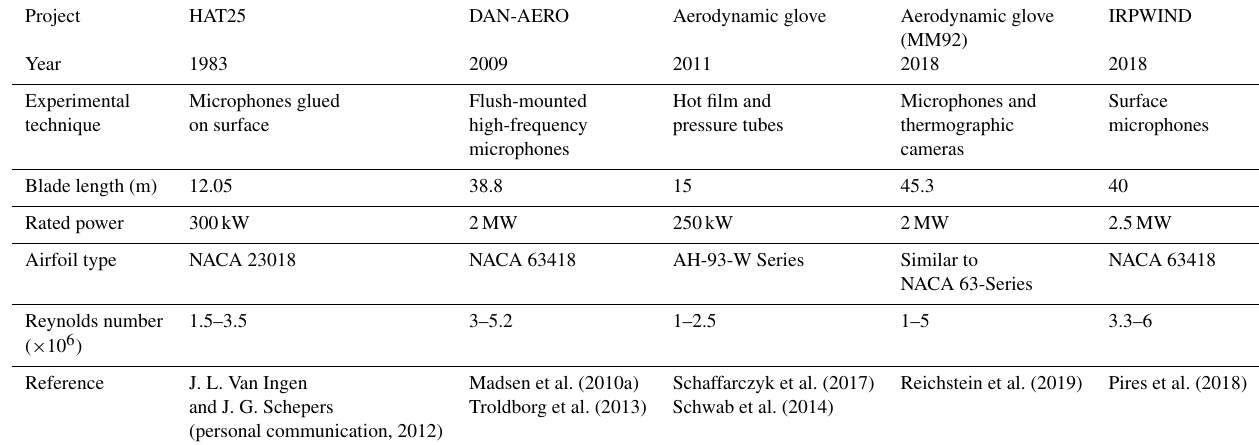
Table 1. Field experiments on boundary layer transition on wind turbine blades (regenerated and extended from Özçakmak (2020)).